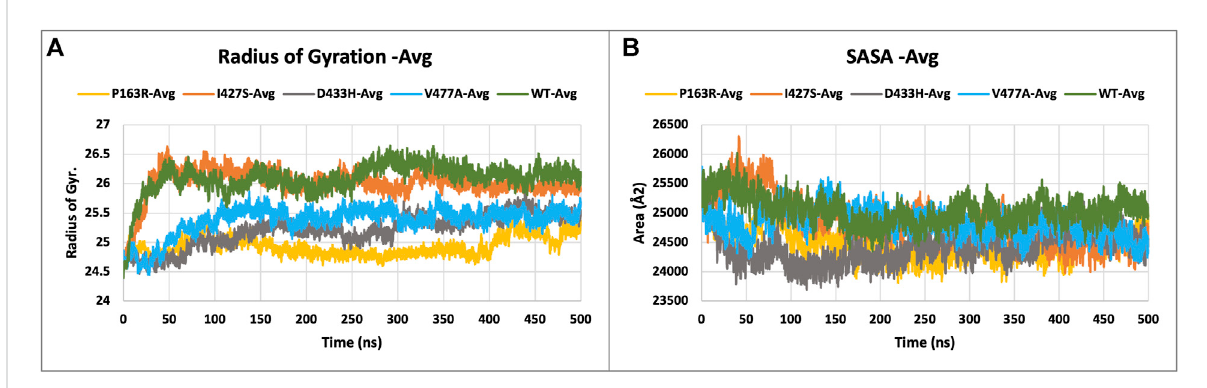
FIGURE 5 Plot (A) describing the radius of gyration (Rg), and (B) solvent accessible surface area (SASA), measurement of WT and mutant proteins throughout the